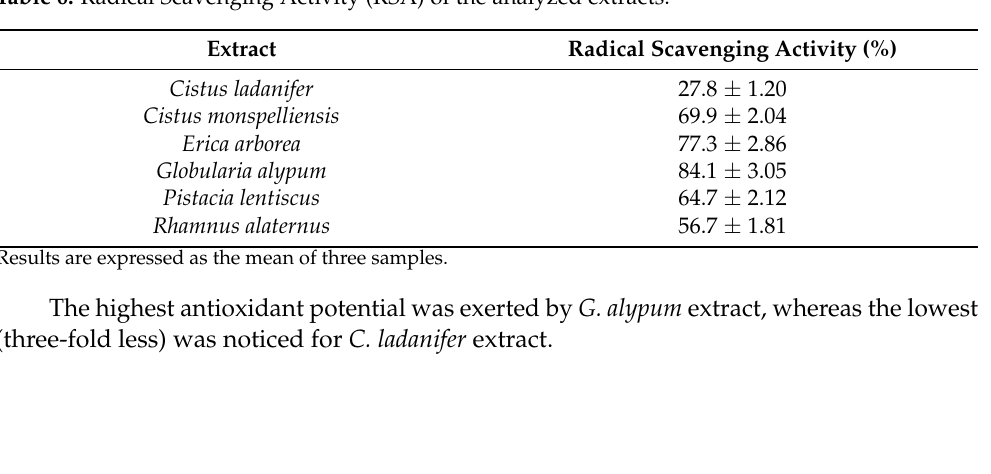
Table 6. Radical Scavenging Activity (RSA) of the analyzed